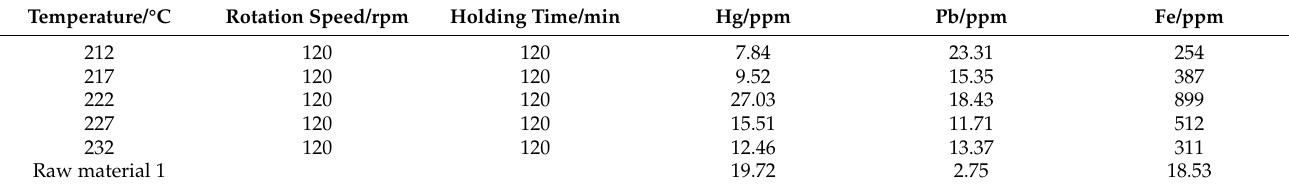
Table 3. The compositions of crystallization products at different temperatures.